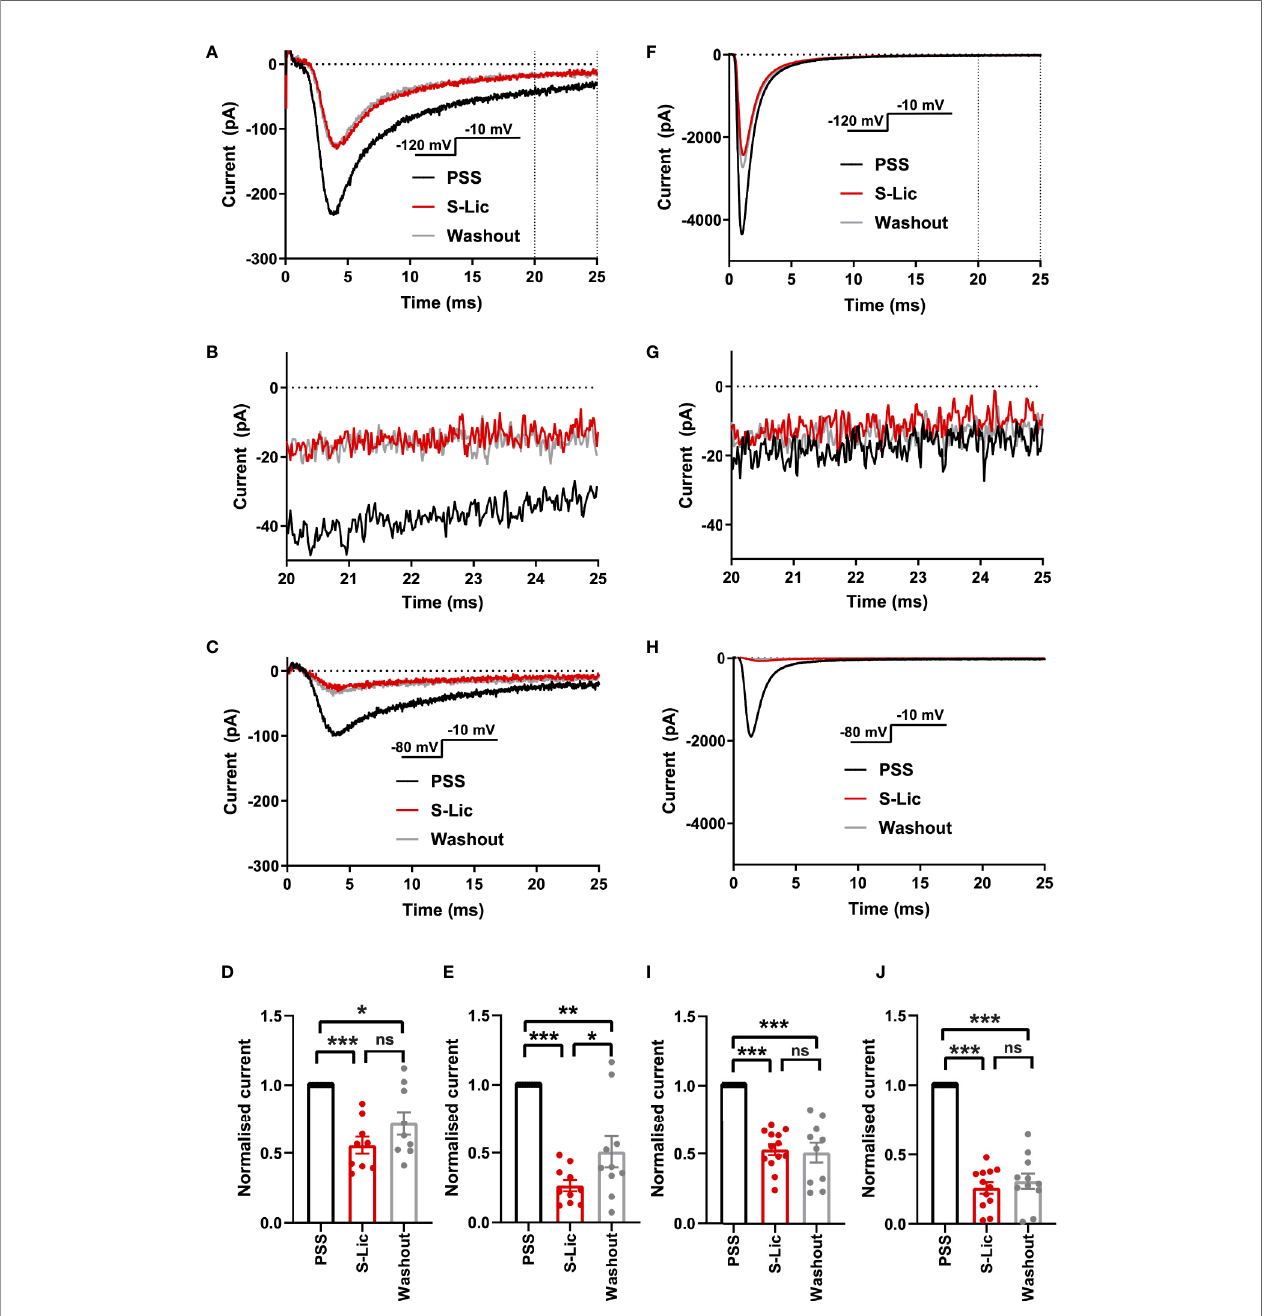
FIGURE 3 | Effect of S-licarbazepine on Na v 1.5 currents. (A) Representative Na + currents in an MDA-MB-231 cell elicited by a depolarisation from -120 to -10 mV in physiological saline solution (PSS; black), S-licarbazepine (S-Lic; 300 m M; red) and after washout (grey). Dotted vertical lines de fi ne the time period magni fi ed in (B) . (B) Representative persistent Na + currents in an MDA-MB-231 cell elicited by a depolarisation from -120 to -10 mV. (C) Representative Na + currents in an MDA-MB- 231 cell elicited by a depolarisation from -80 to -10 mV. (D) Normalized Na + currents in MDA-MB-231 cells elicited by a depolarisation from -120 to -10 mV. (E) Normalized Na + currents in MDA-MB-231 cells elicited by a depolarisation from -80 to -10 mV. (F) Representative Na + currents in a HEK-Na v 1.5 cell elicited by a depolarisation from -120 to -10 mV in PSS (black), S-Lic (300 m M; red) and after washout (grey). Dotted vertical lines de fi ne the time period magni fi ed in (G) . (G) Representative persistent Na + currents in a HEK-Na v 1.5 cell elicited by a depolarisation from -120 to -10 mV. (H) Representative Na + currents in a HEK-Na v 1.5 cell elicited by a depolarisation from -80 to -10 mV. (I) Normalized Na + currents in HEK-Na v 1.5 cells elicited by a depolarisation from -120 to -10 mV. (J) Normalized Na + currents in HEK-Na v 1.5 cells elicited by a depolarisation from -80 to -10 mV. Results are mean + SEM. *P ≤ 0.05; ***P ≤ 0.001; one-way ANOVA with Tukey tests (n = 9-13). NS, not signi fi